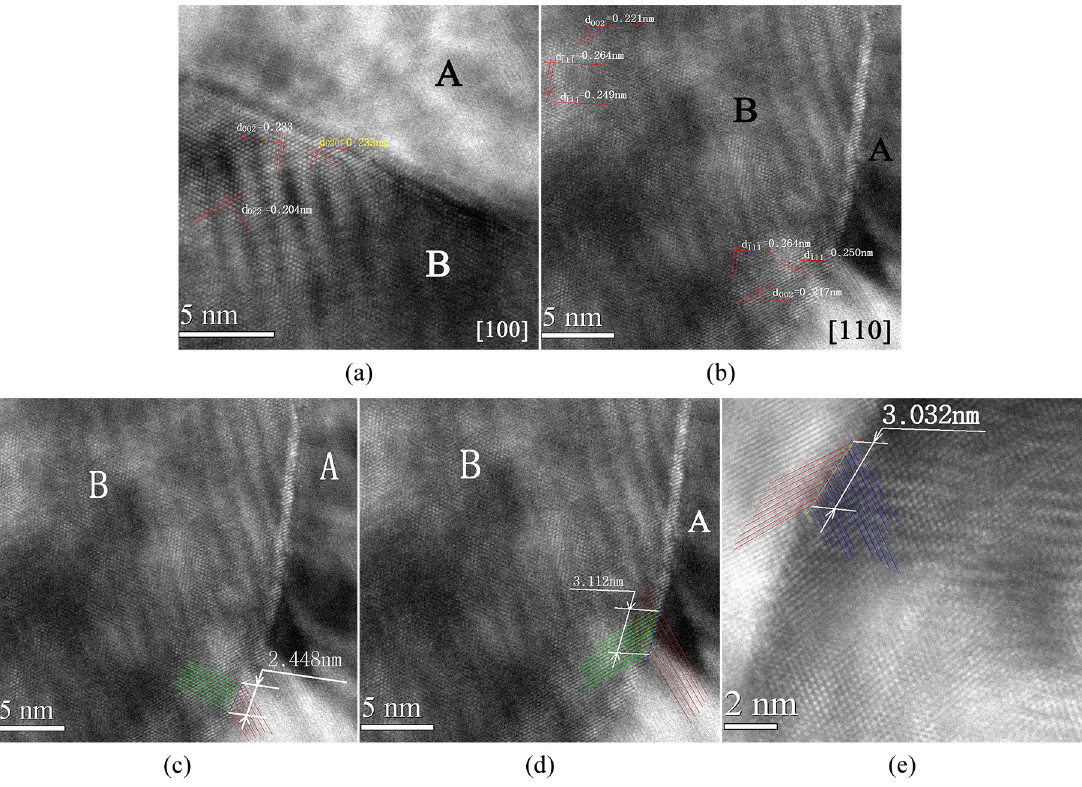
Figure 11. HRTEM micrographs of 95nm precipitated phase in 4µm Fe-1.3Mn powder alloy. Area ‘A’ for matrix phase and area ‘B’ for precipitated phase. “d” is the interplanar spacing value of each lattice plane; (c), (d) and (e) show the mismatch condition between precipitated phase and matrix lattice plane. From high resolution image, left part in (d), which was obtained from (a).